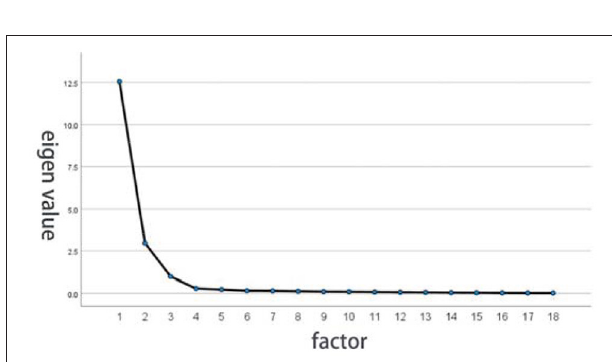
FIGURE 6 | Eigenvalue factor analysis of screen